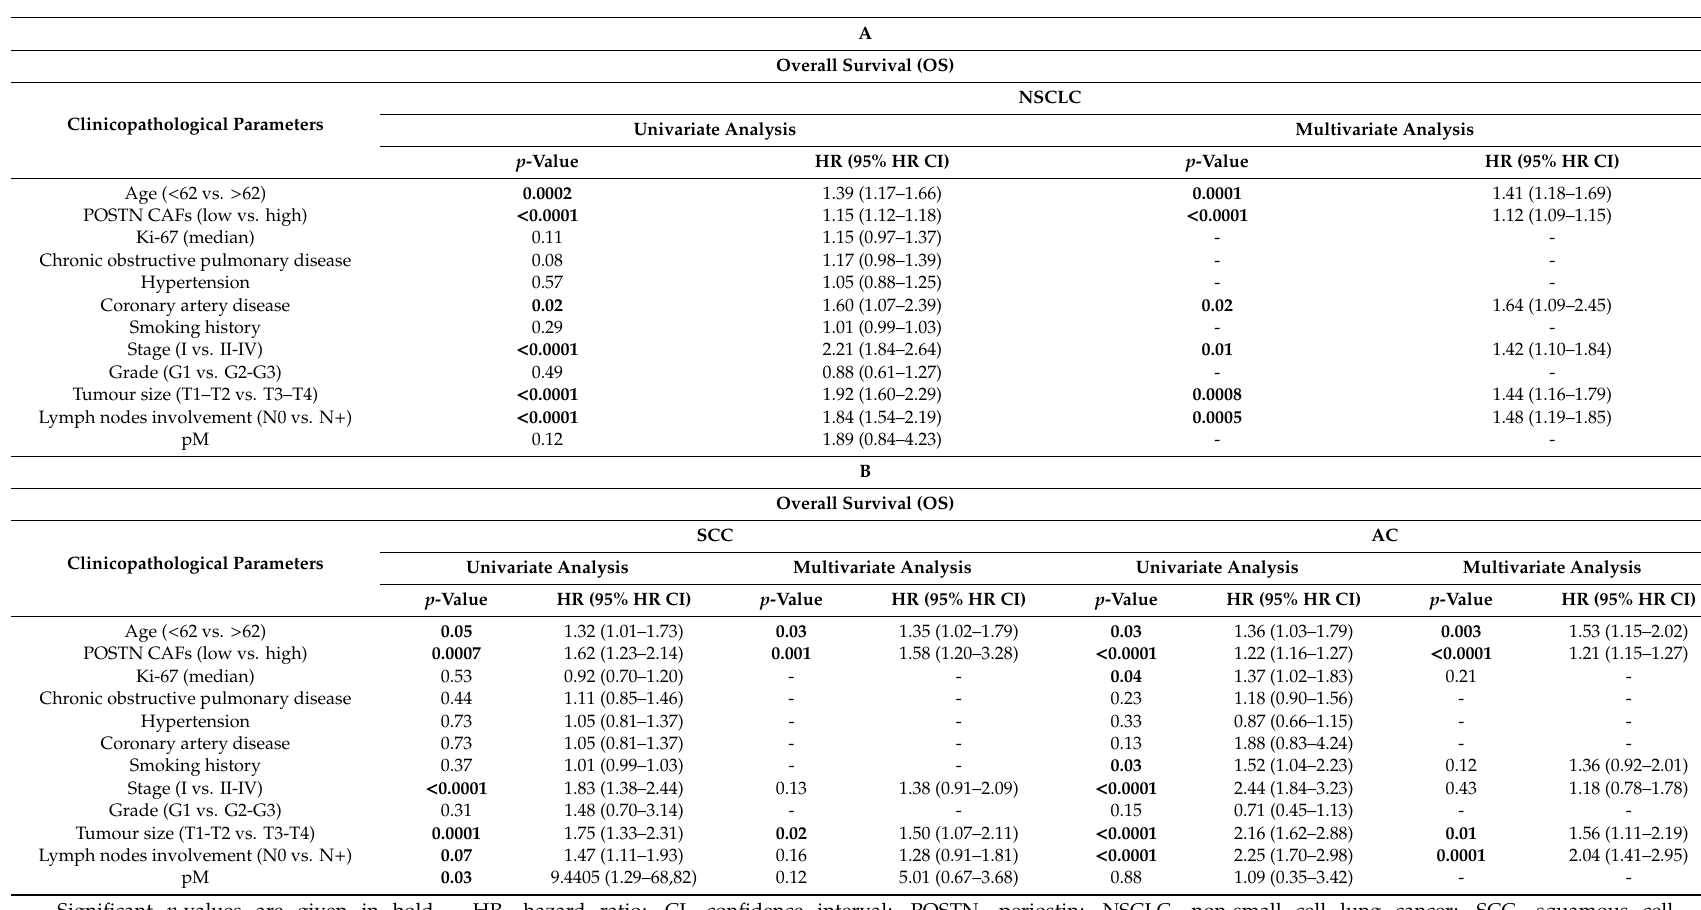
Table 1. Survival analysis of ( A ) the whole cohort and ( B ) squamous cell cancer (SCC) and adenocarcinoma (AC). Cox proportional hazards